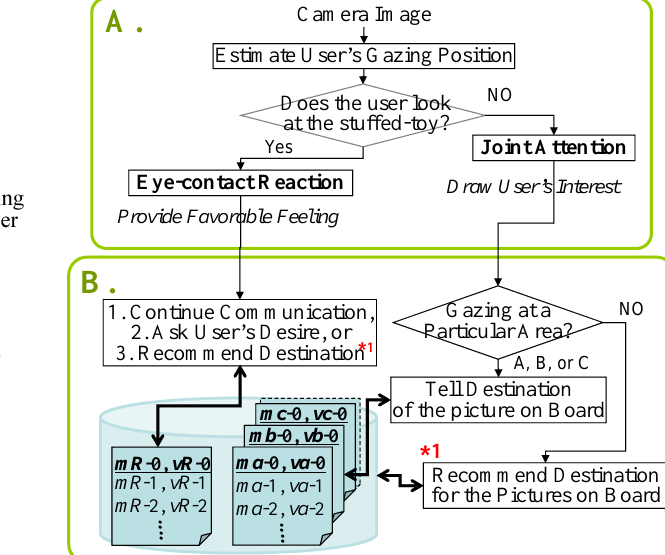
Figure 4. System Flow’s Implementation